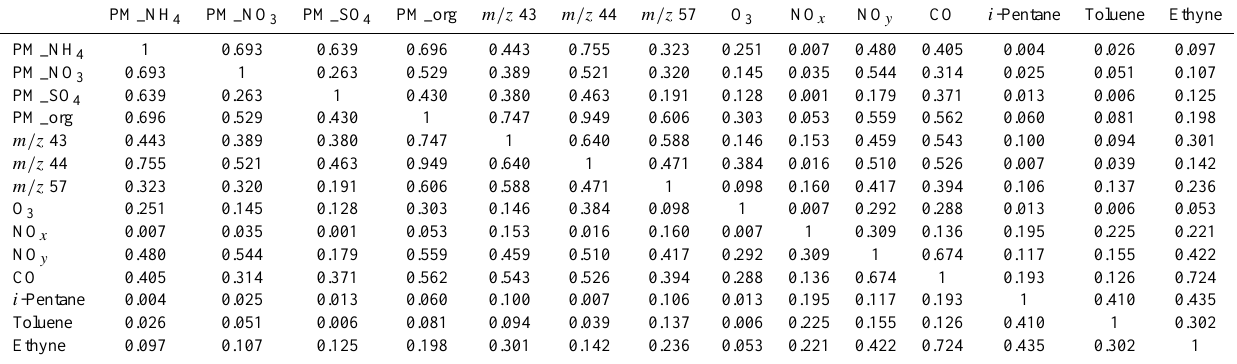
Table 2. Coefficients of determination for correlations between chemical species